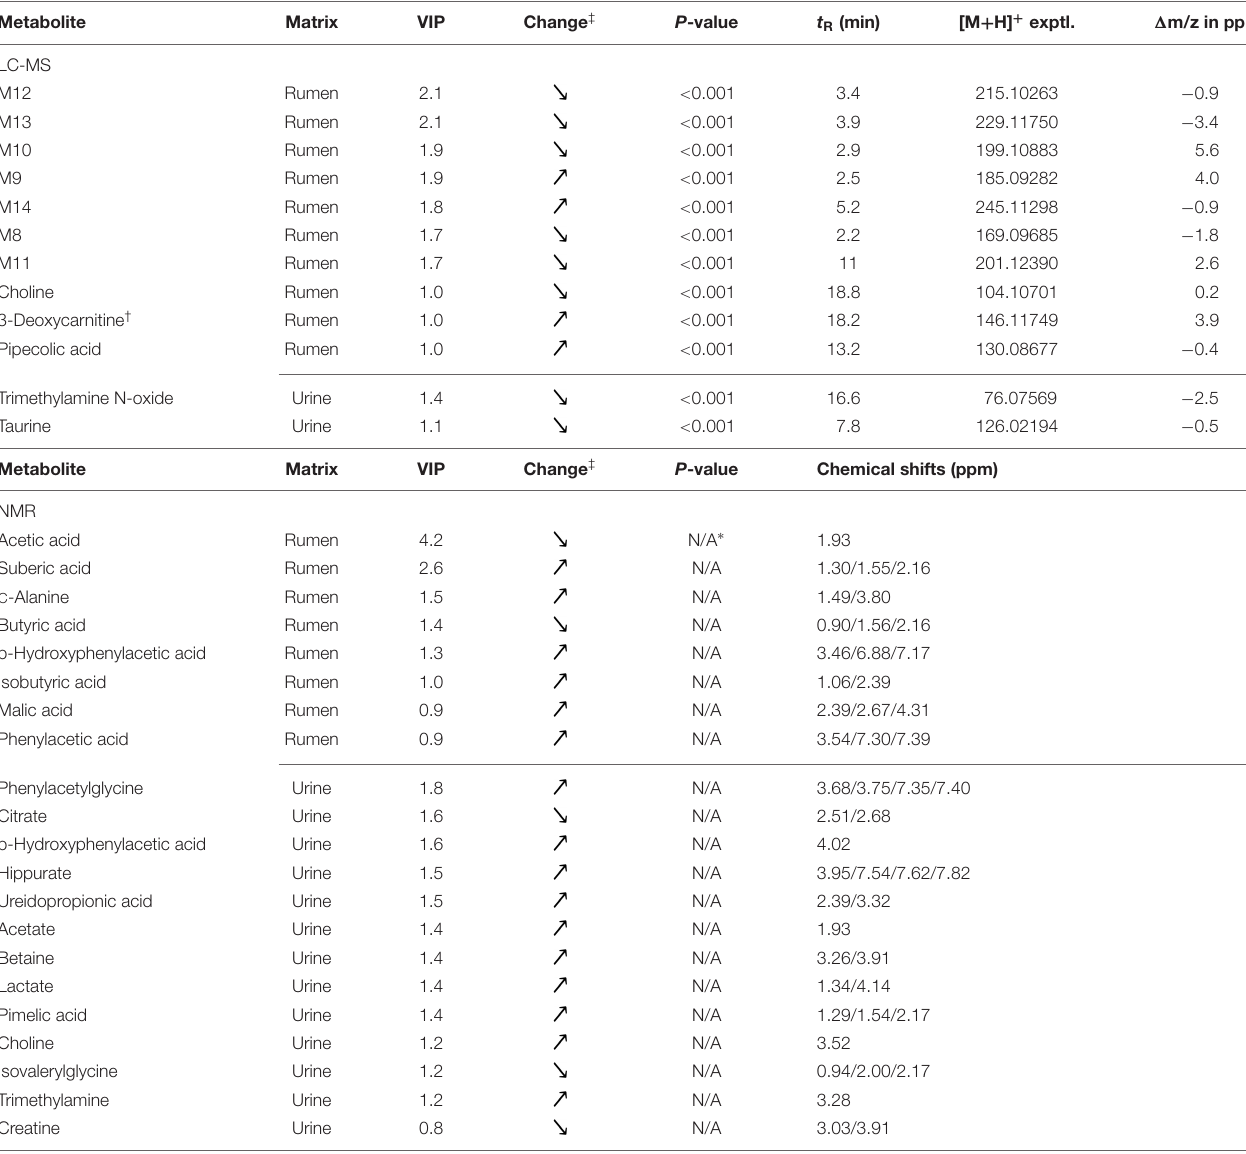
TABLE 4 | Changes in rumen and urine metabolites detected by LC-MS/ToF and NMR between control and treated lambs at 20 weeks. Metabolite